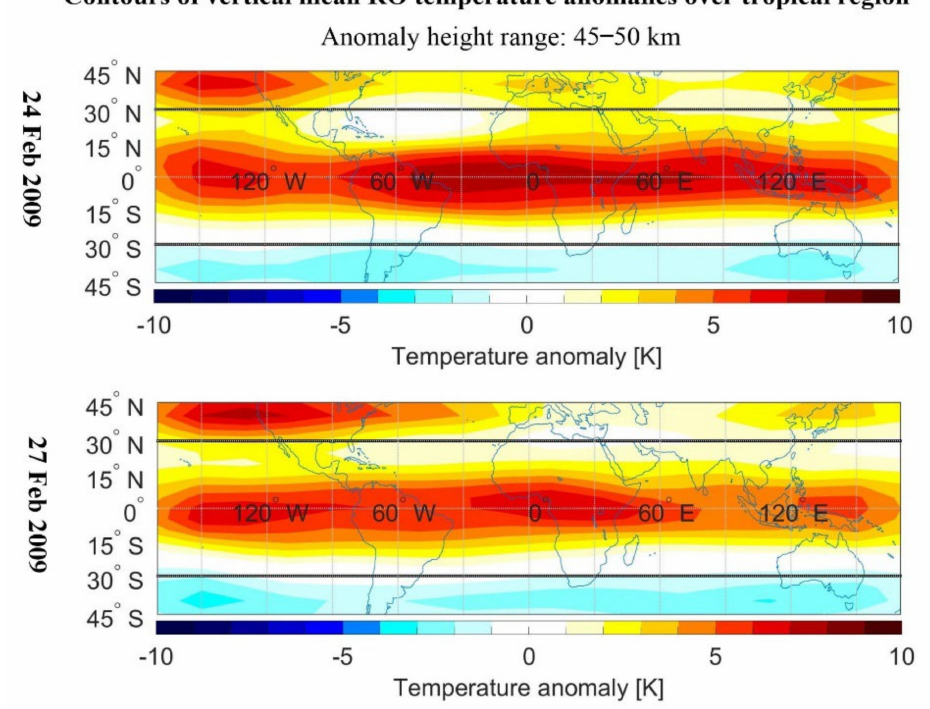
Figure 9. Latitude and longitude sectors of gridded mean RO temperature anomalies obtained from upward altitude layer 45–50 km on two exemplary days of 24 and 27 February